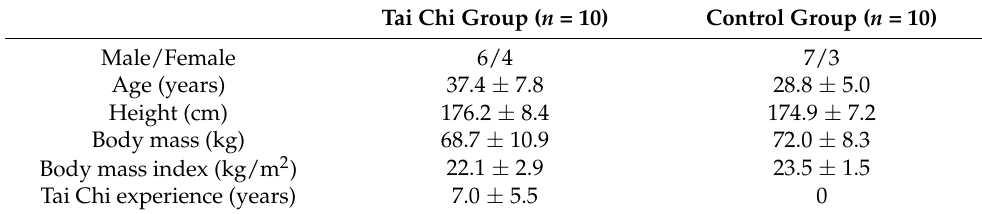
Table 1. Basic participant